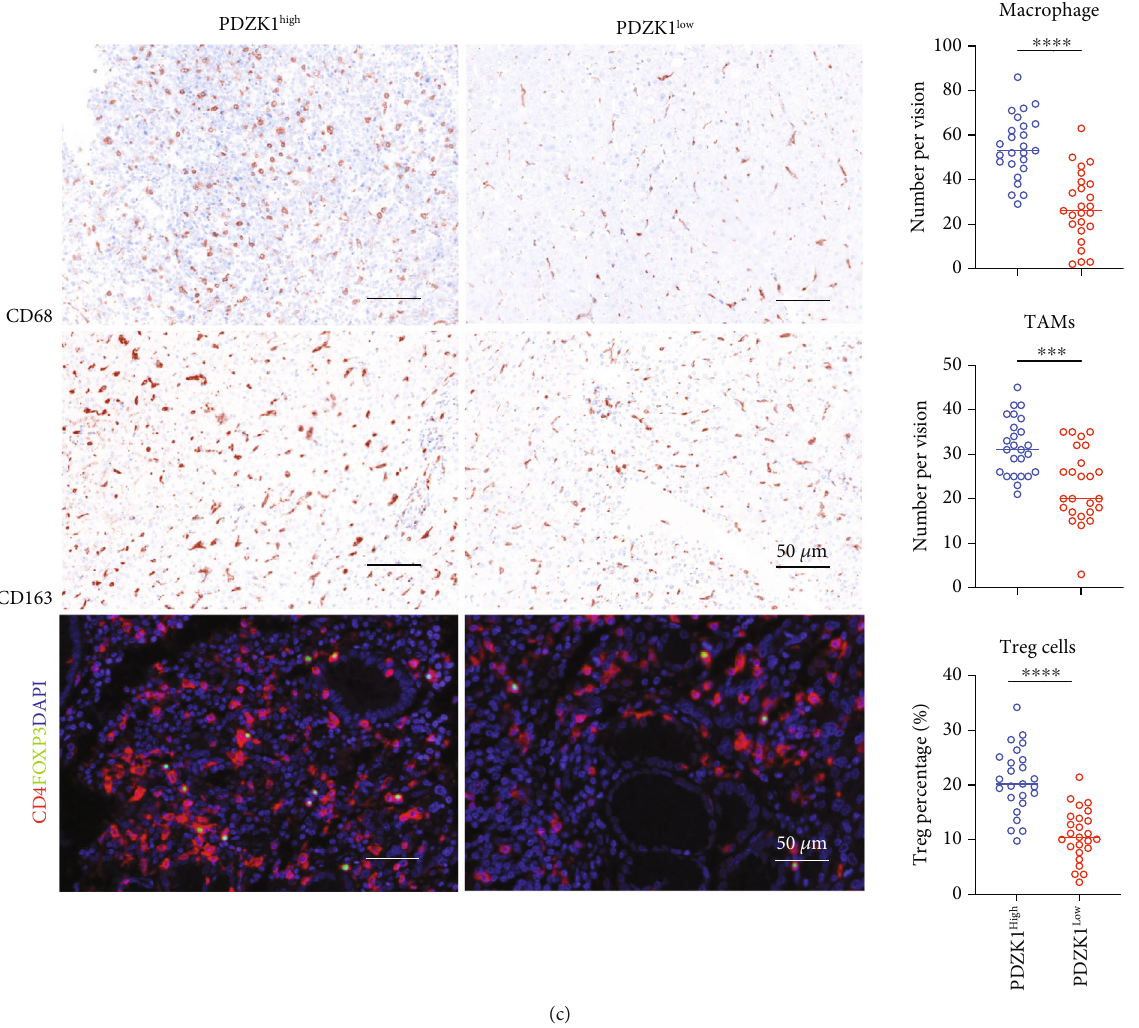
Figure 5: Expression of PDZK1 in HCC tissues was associated with Treg, and tumor-associated macrophages (TAMs) induced immunosuppression. (a) ssGSEA analysis for PDZK1 top 20 high and low expression TCGA samples by using previously reported gene sets. (b) GSEA analysis for PDZK1 top 20 high and low expression TCGA samples. (c) IHC and multiple color IHC staining for CD68, CD163, and CD4/FOXP3 in PDZK1 high and low expression samples. Data are presented as mean ± SEM and were analyzed using Student ’ s t -test ( ∗ P < 0 : 05 , ∗∗ P < 0 : 01 ; ns: not signi fi cant, P > 0 : 05